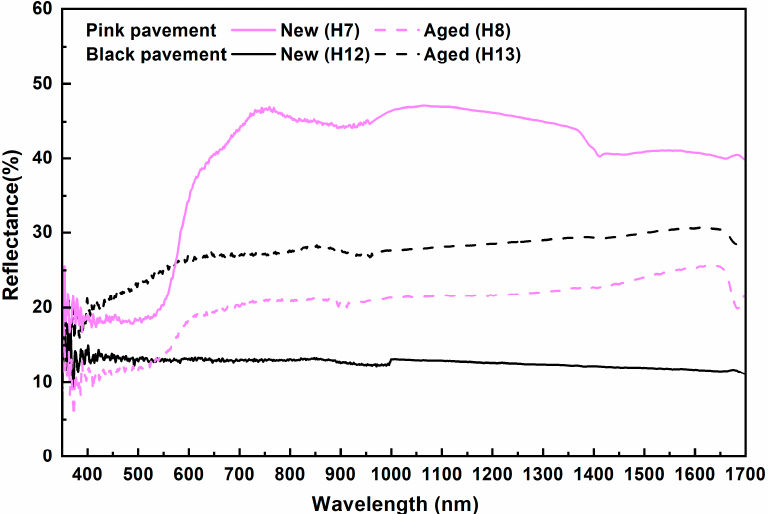
Figure 7. Mean reflectance spectra of the different horizontal surface finishes shown in Figure 2. A different behavior of the black pavement upon aging is derived from the optical characterization of the H12 (new) and H13 (aged) samples. The new pavement shows a low and nearly constant reflectance along the solar spectral range that accounts for the high solar absorptance (0.87), the low L* value (42.8), and the a* and b* values close to zero, indicating that no color predominates in the black surface. Upon aging, the reflectance of the surface clearly increases at all the wavelengths, giving rise to the decrease in the solar absorptance down to 0.74, the increase in the L* value up to 57.1, and the coherently lighter appearance of the surface (Figure 2). The spectral curve is still flat, except for a smooth decrease in reflectance for decreasing wavelengths in the visible range, below 590 nm, that accounts for the slight increase in the b* coordinate. The change in α s observed in this case is similar to that previously reported for the aging effect in asphalt pavements [40].